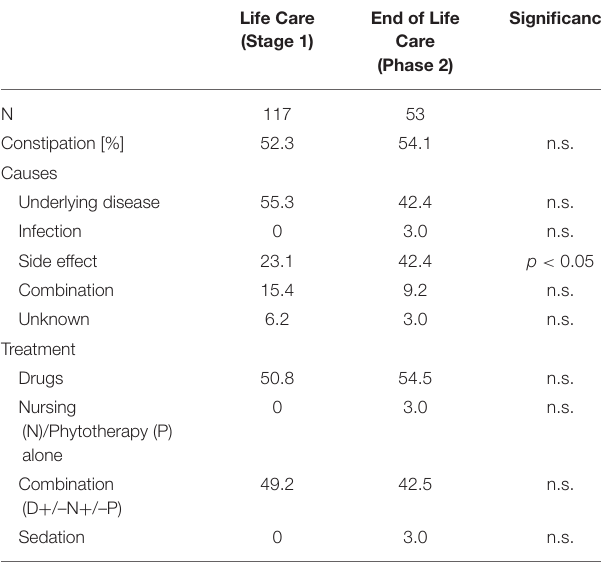
TABLE 4 | Causes/treatment of